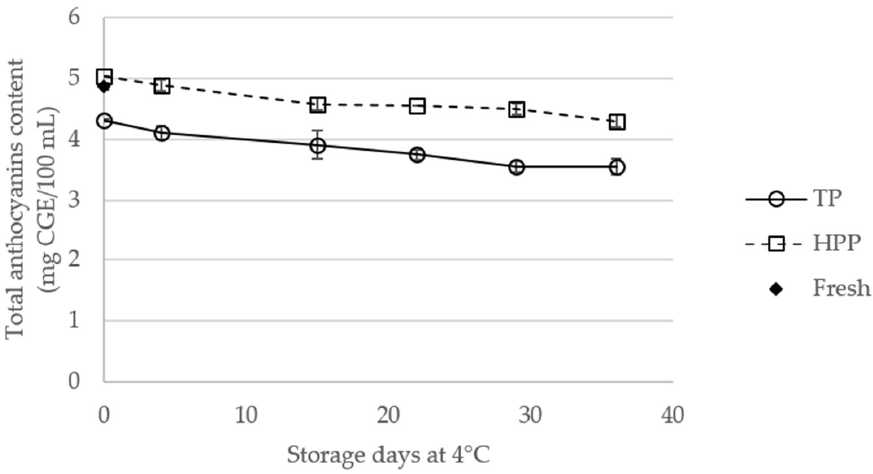
Figure 3. Total anthocyanin content (expressed as cyanidin-3-glucoside equivalents (CGE)) of fresh and thermal pasteurized (TP) and high-pressure processed (HPP) orange juices during storage at 4